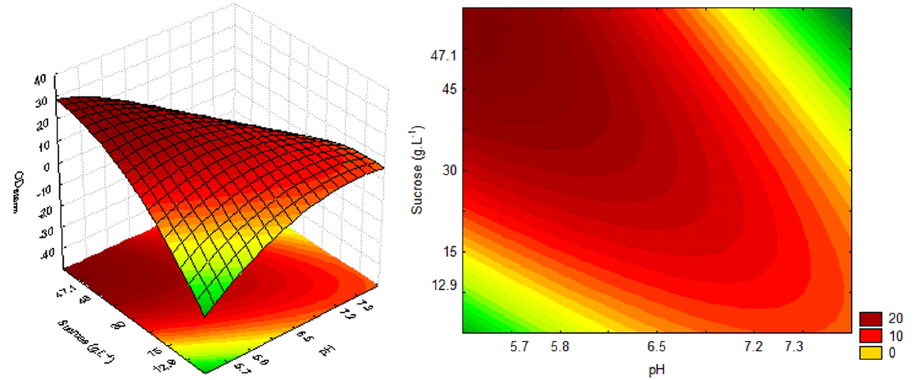
Fig 2. Response and contour surfacesas a function of sucrose concentration and pH for OD 600nm .